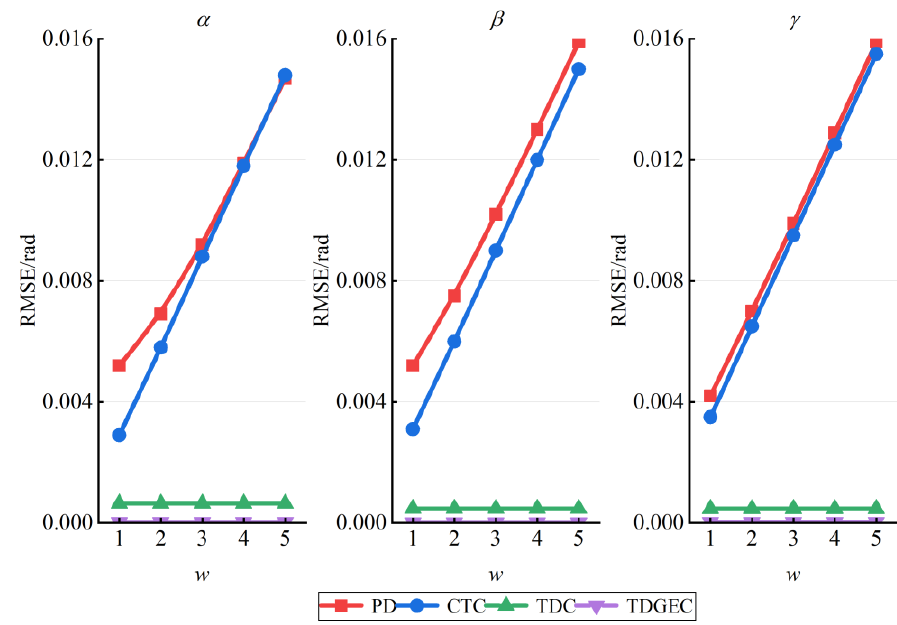
Figure 9. RMSE under different w .